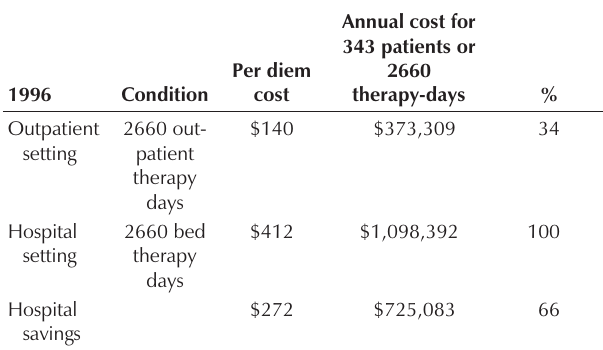
Type of outpatient intravenous antibiotics